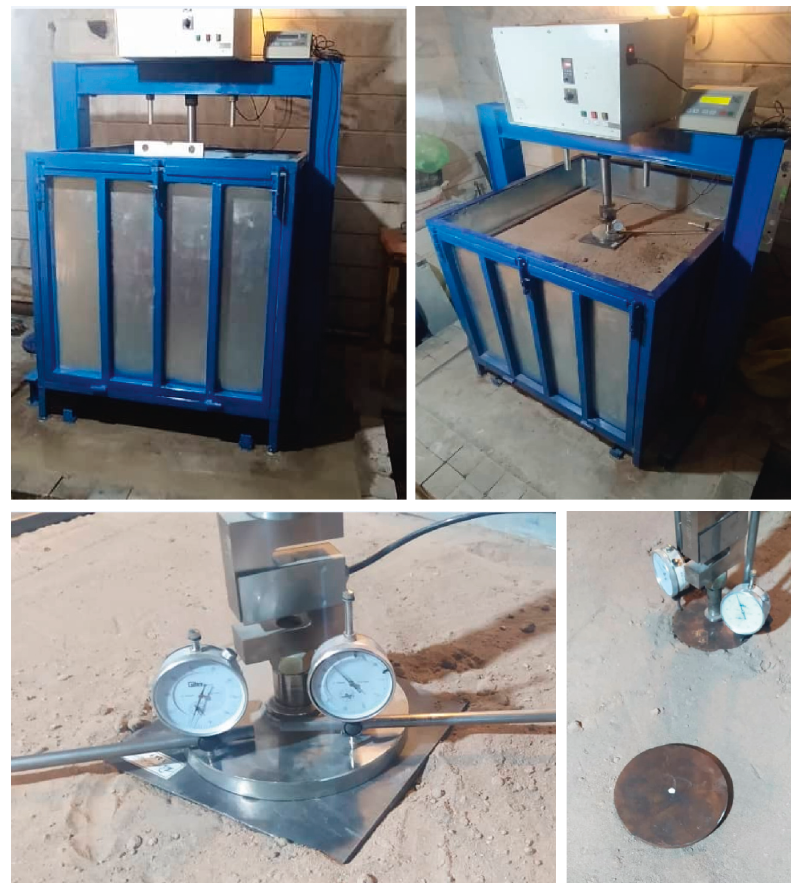
Figure 4: Pi simulator for large-scale and load plate tests with displacement and dynamometer